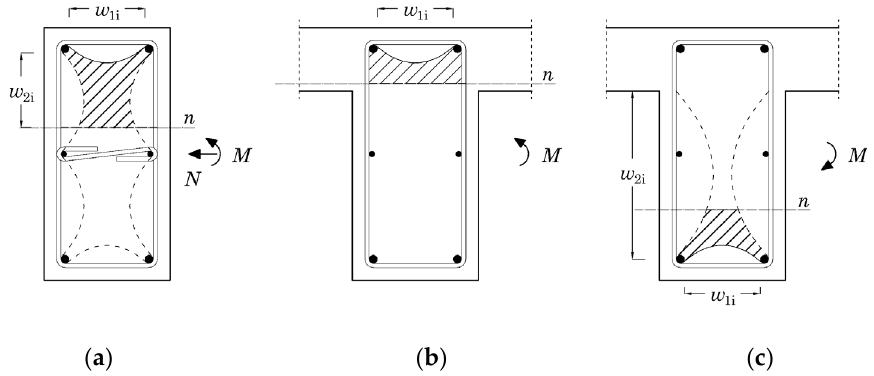
Figure 3. Confined concrete in the plane of stirrups for ( a ) columns, ( b ) beams with positive bending moment, and ( c ) beams with negative bending